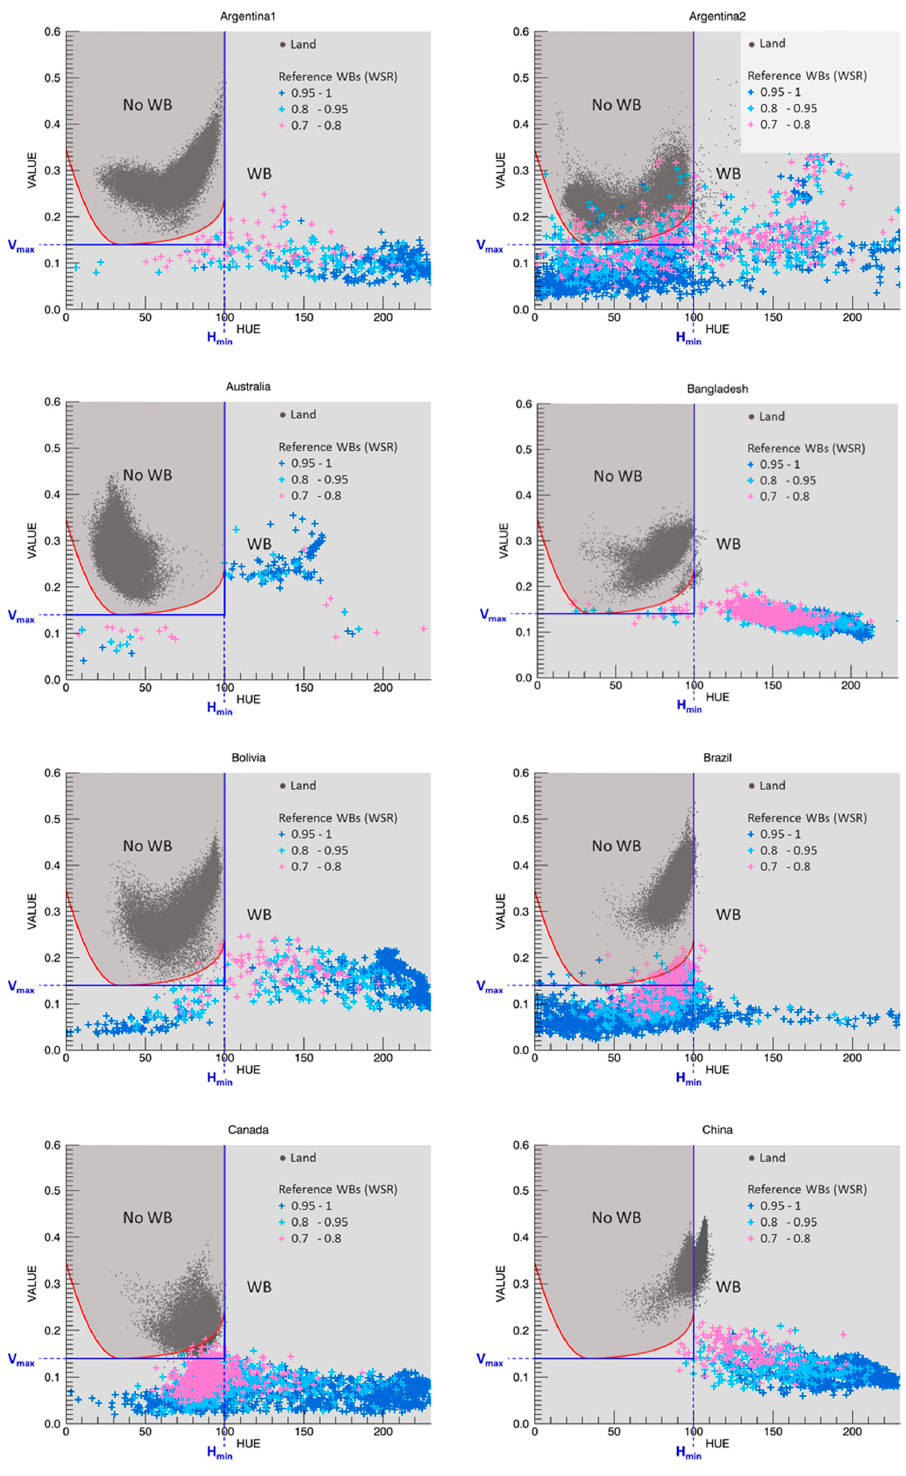
Figure B1. 2D scatter plots of the first eight test areas.